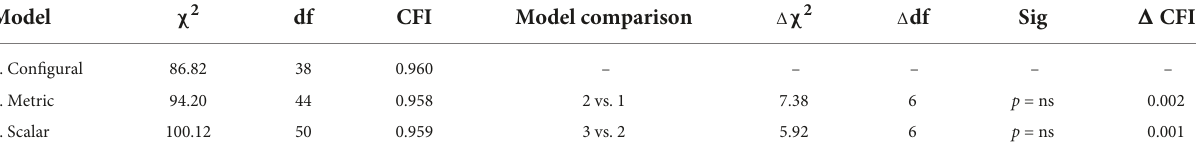
TABLE 3 Factorial invariance across gender for the SMM